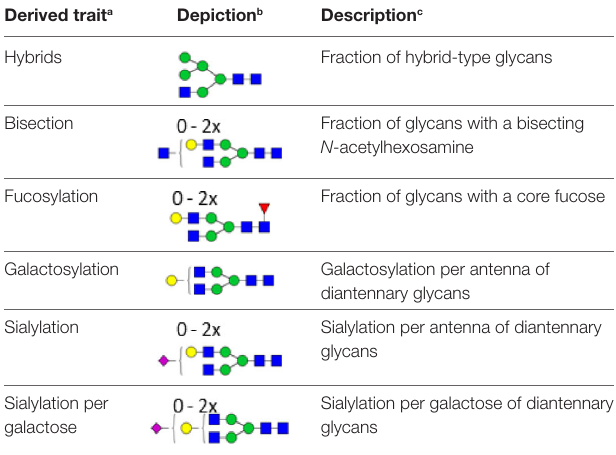
derived traits show the minimally required composition to contribute to a trait. c For detailed calculations of the traits, see Table S2 in Supplementary Material.